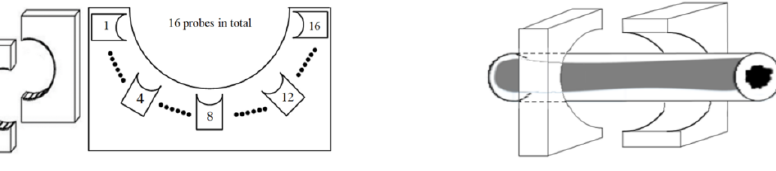
Figure 4. Schematic diagram of ultrasonic array detection.